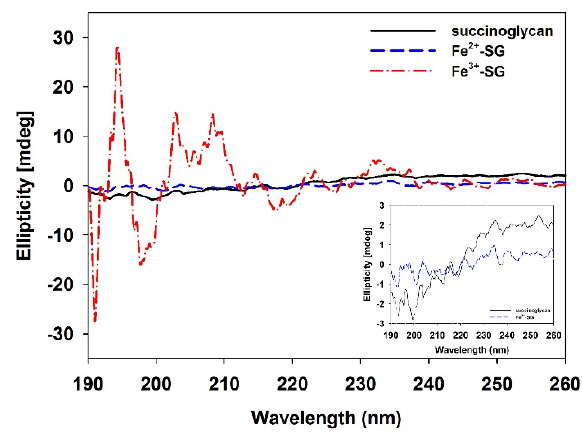
Figure 4. Circular dichroism (CD) spectra of the succinoglycan, succinoglycan mixed with the Fe 2+ solution (Fe 2+ -SG), and Fe 3+ solution (Fe 3+ -SG). The inset shows the spectra that details the succinoglycan and Fe 2+ -SG.